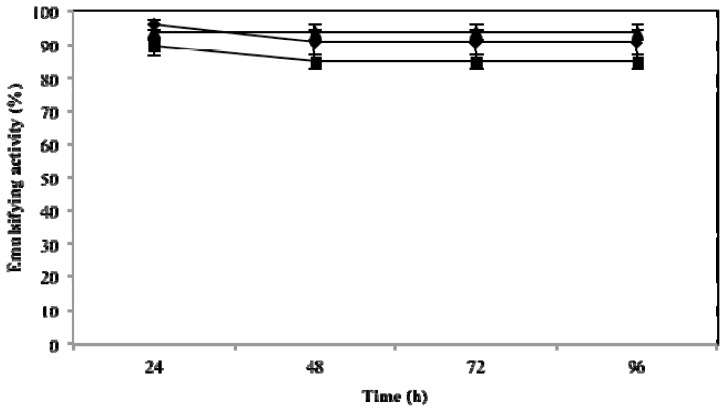
Emulsifying activity of microbactan on motor oil at different pH values. pH 4 (●), pH 7 (■) and pH 10 (▲).Values represent means ± SD (n = 3).